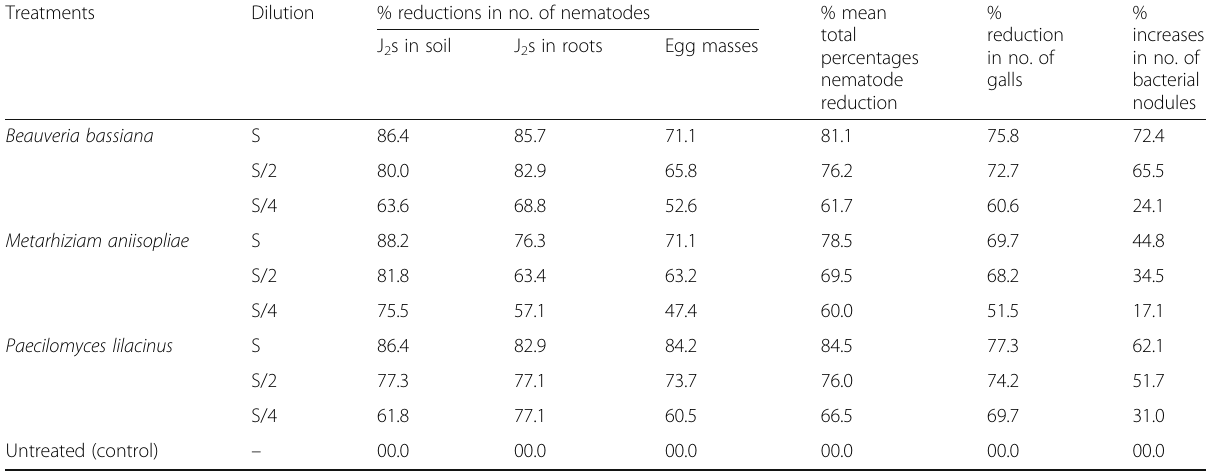
Table 5 Percentages of reduction of number of the root-knot nematode, Meloidogyne incognita infecting cowpea, number of galls and percentages of increase in number of bacterial nodules as affected by three culture filtrates from Beauveria bassiana , Metarhiziam aniisopliae , and Paecilomyces lilacinus Treatments Dilution % reductions in no. of